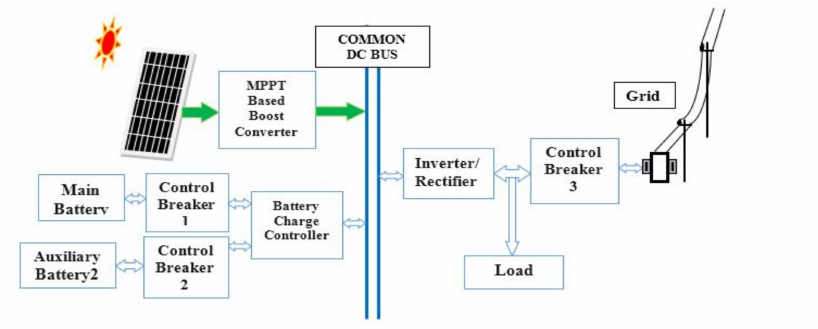
Figure 2. Proposed solar power generation scheme with dual battery storage systems.